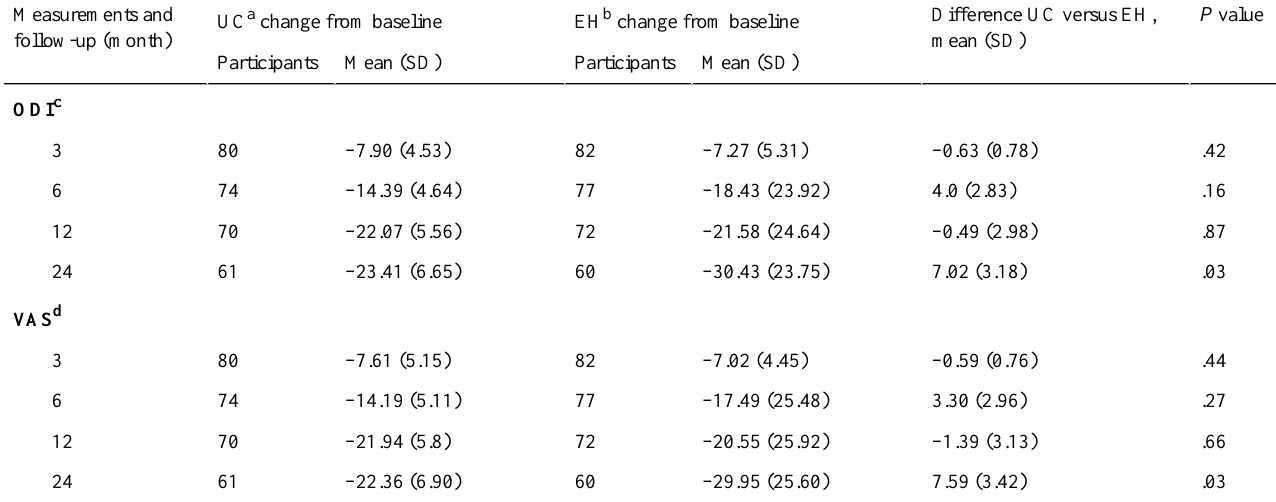
Table 3. Primary outcomes change from baseline and between-group difference.